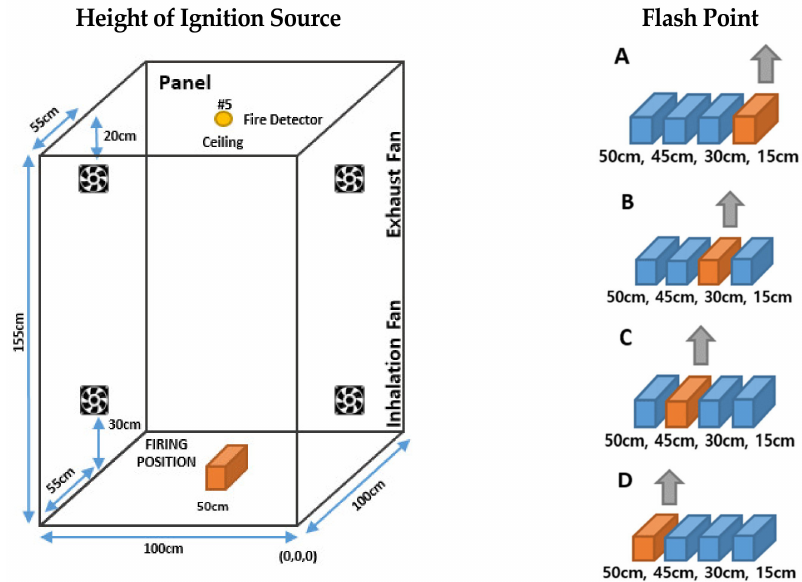
Figure 9. Sample installation on